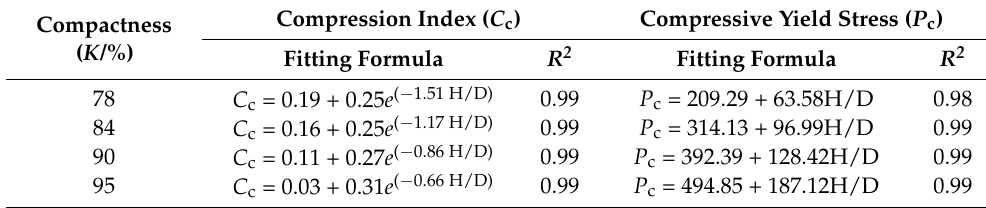
Table 2. Fitting results of compression parameters.